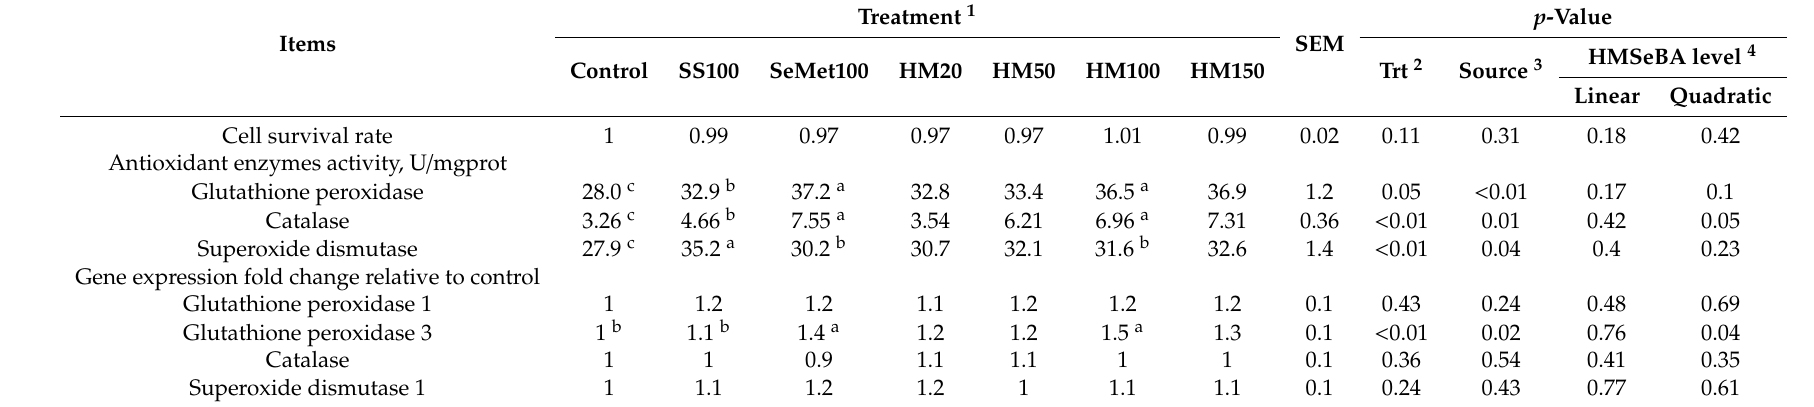
Table 3. E ff ect of di ff erent Se sources on cell survival rate and antioxidation with